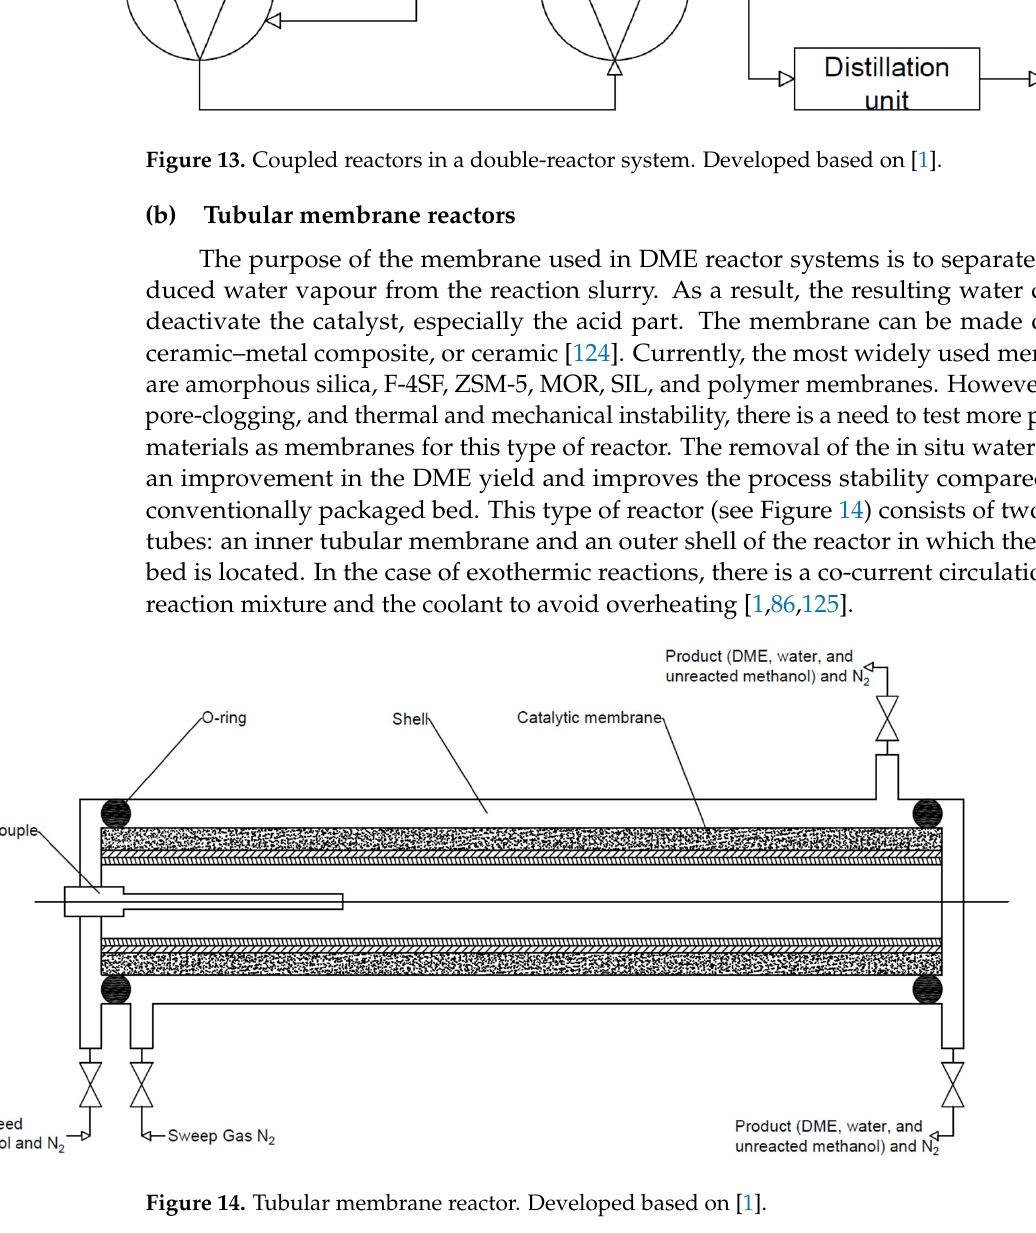
Figure 14. Tubular membrane reactor. Developed based on [1] (c)